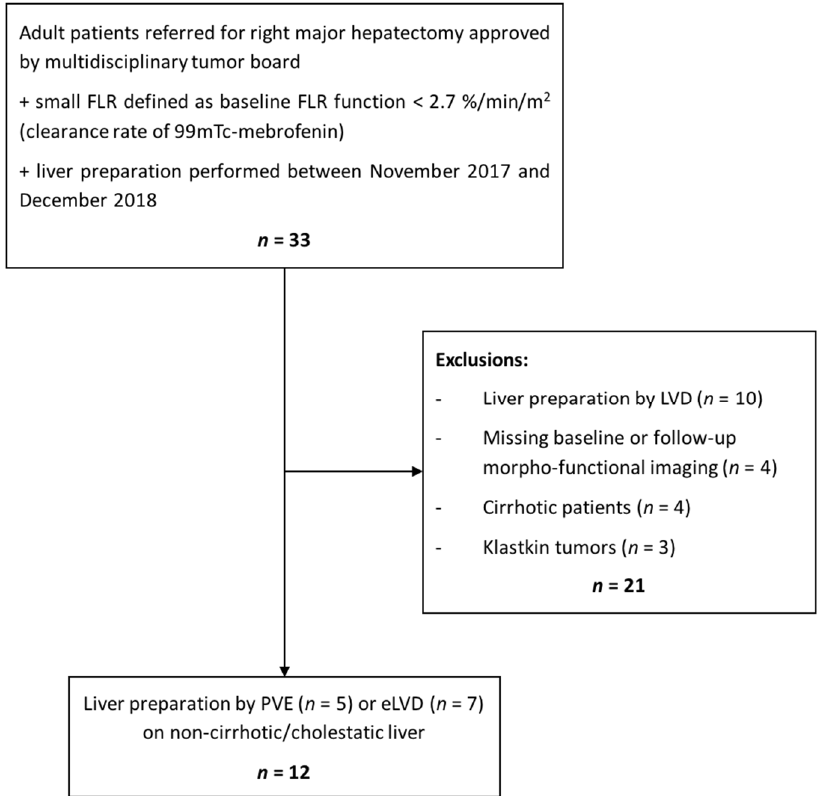
Figure 1. Study flowchart. FLR = future remnant liver; LVD = liver venous deprivation; PVE = portal vein embolization; eLVD = extended liver venous deprivation.